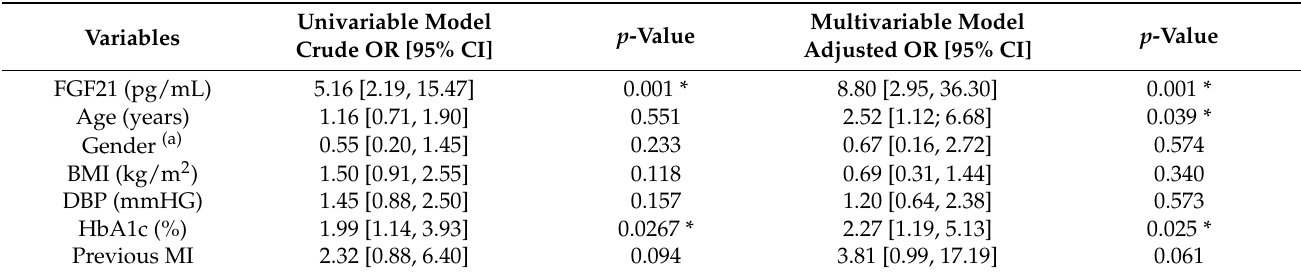
Table 3. Logistic regression analysis of factors used to separate patients with diabetes and heart failure from those without heart failure.